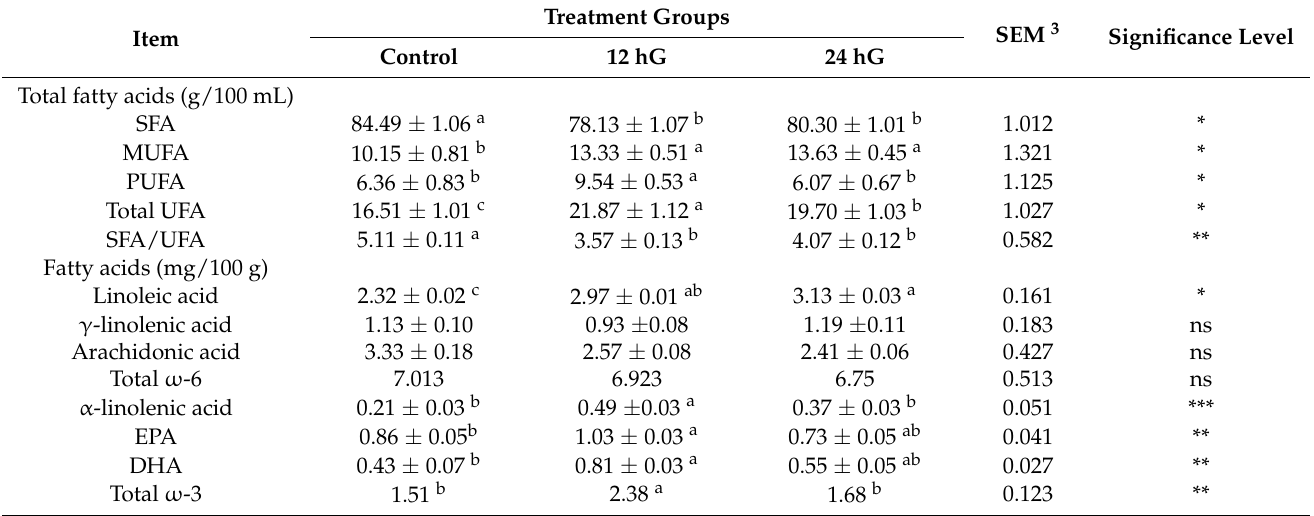
Table 5. Milk fatty acid composition in dairy cows according to treatment